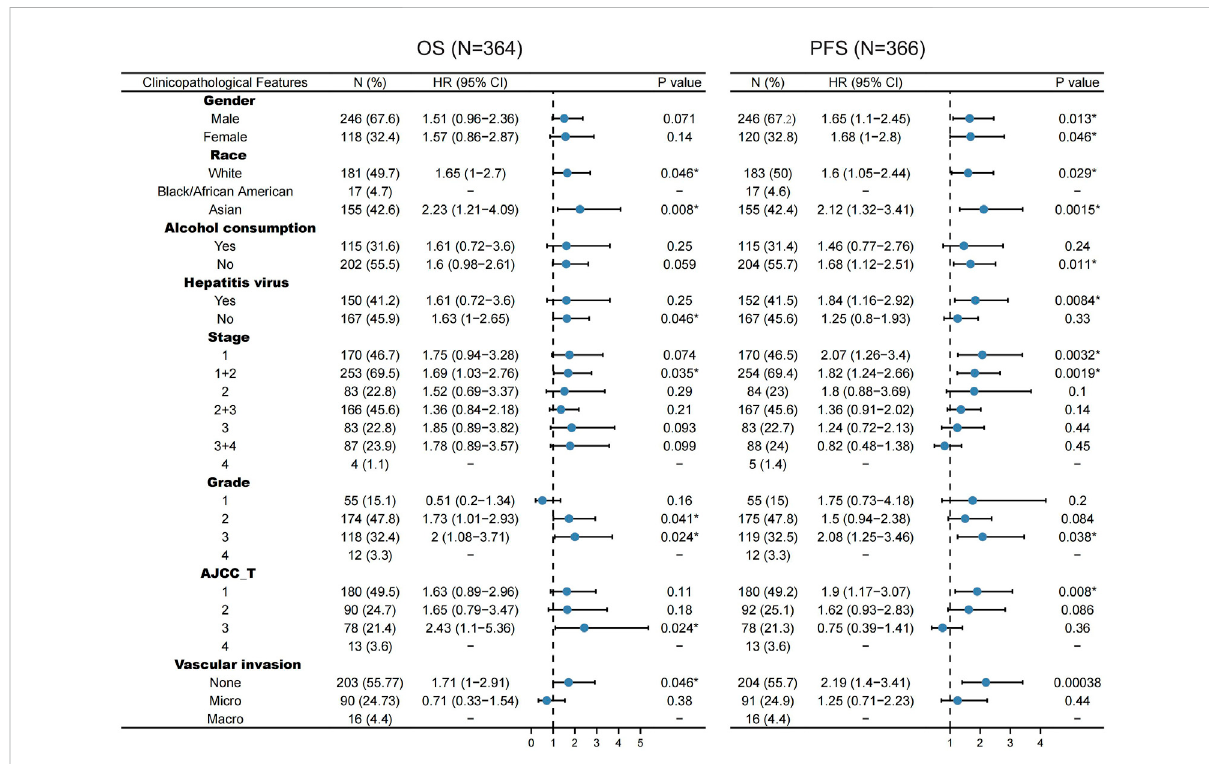
FIGURE 4 Correlation of WTAP mRNA expression with OS ( n = 364) and PFS ( n = 366) in liver hepatocellular carcinoma with various clinicopathological features. Blue dots stand for hazard ratio. Short bars appear due to small sample capacity for parameters, so that hazard ratio and corresponding p value cannot be calculated. OS, overall survival; PFS, progression free survival. * p < 0.05.